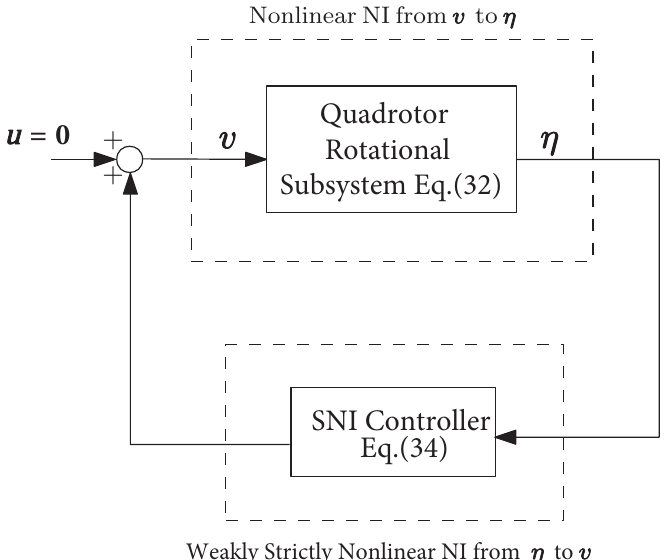
Figure 6. Block diagram of the proposed attitude control system comprised of a positive feedback interconnection of the rotational subsystem (33) and SNI controller